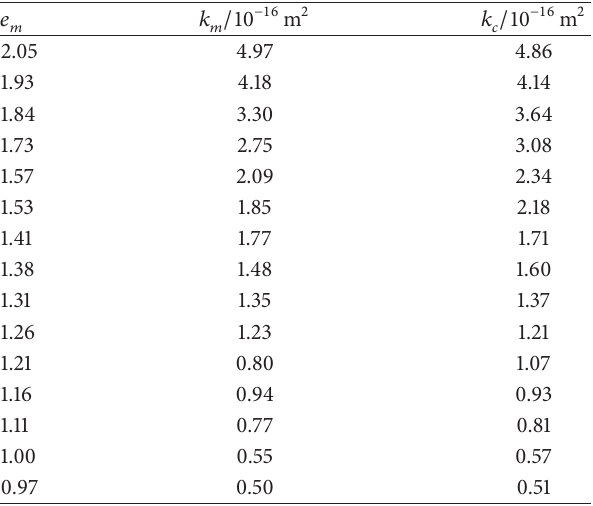
Table 3: Calculated and measured permeabilities of kaolin clay using the R-W model.